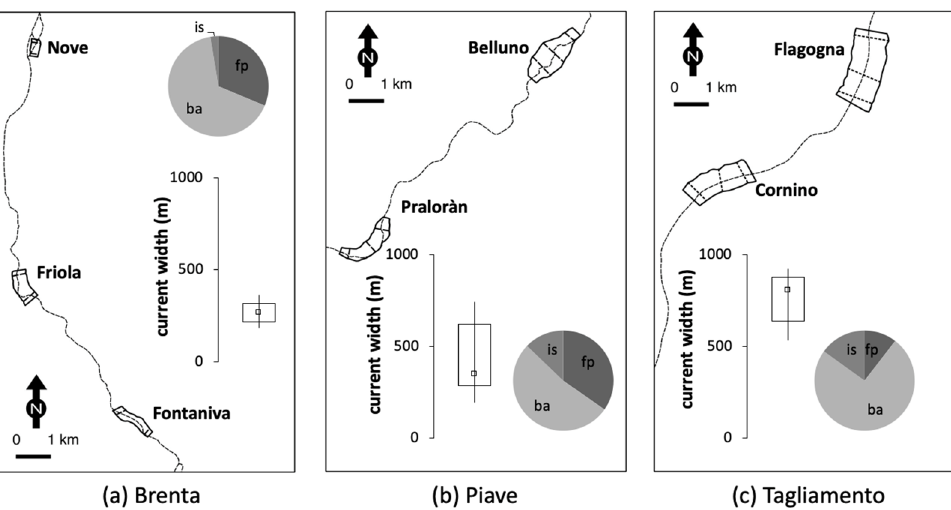
Figure 7. The studied sub-reaches, frequency of geomorphic types (fp: floodplain; ba: bar; is: island) in the plots, and the current width of the active channel (box and whisker plots) (from